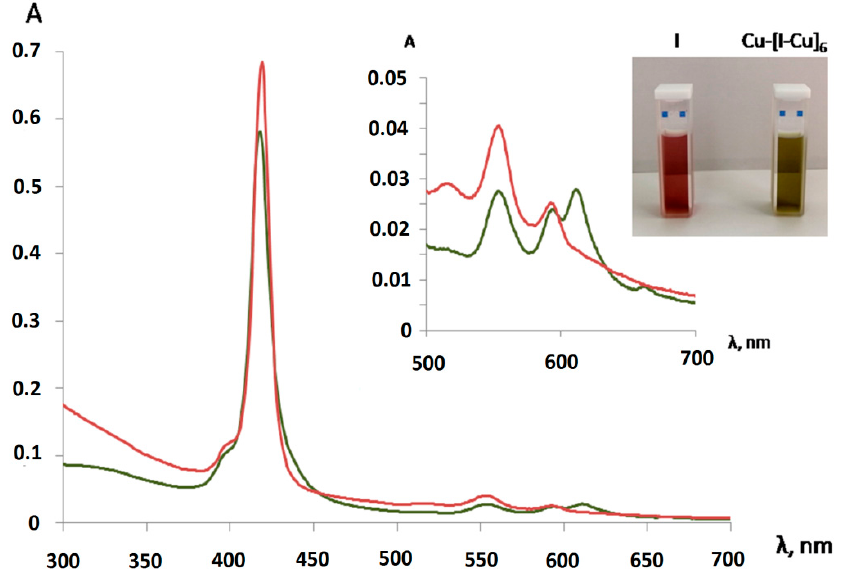
Figure 7. UV-Vis spectra of complex I (red line) and hexamers Cu-[I-Cu] 6 (green line) in water. Table 4. UV-Vis spectra of the studied compounds (I, II, Cu-[I-Cu] 6 , and Cu-[II-Cu] 6 ). Compounds